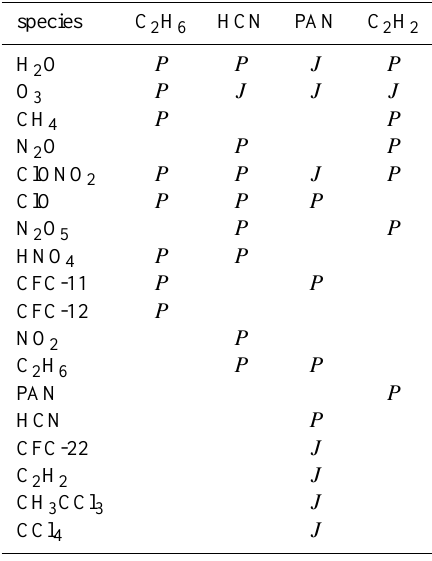
Table 1. Prefitted ( P ) and jointly fitted ( J ) parameters. Spec- tral shift, temperature, line-of-sight and HNO 3 are prefits at all